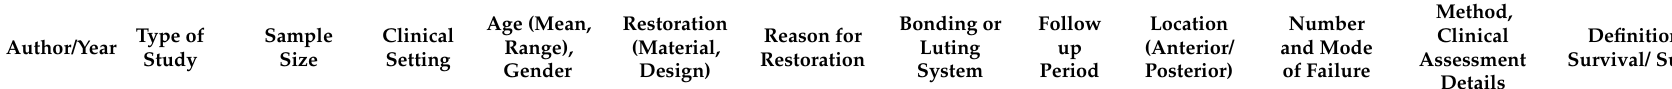
Table 2. Data table of all included